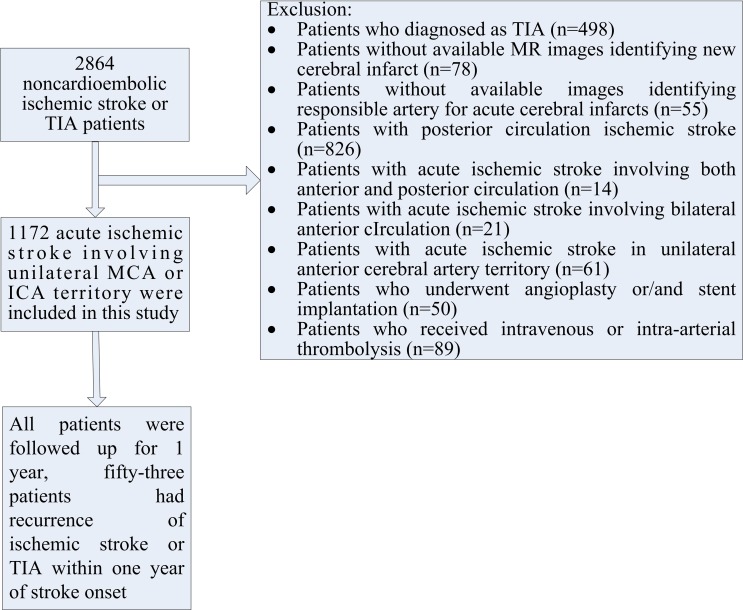
Flow chart of patients enrollment.